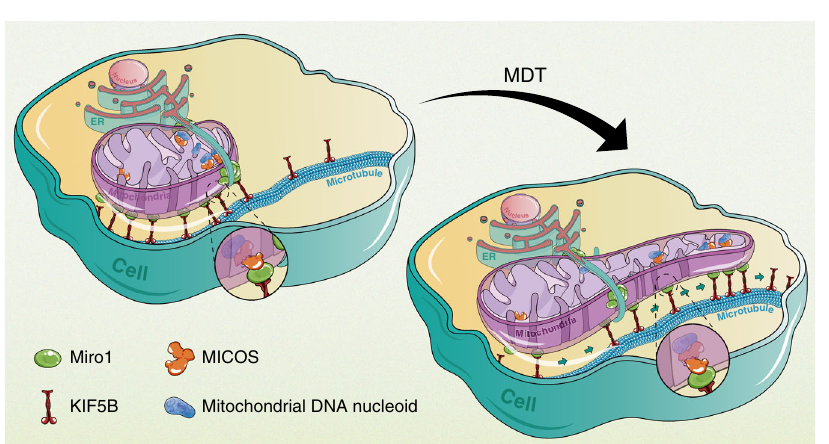
Fig. 5 MDT contributes to nucleoids distribution in peripheral mitochondrial network. a Confocal images of KIF5B − / − NRK cells expressing mito-YFP, TFAM-mCherry, and TET-ON-KIF5B and treated with 0.5 µ g/ml tetracycline. Higher magni fi cations of the white dashed boxes are in the lower panels. Red dashed lines indicate the mitochondrial network boundary before tubulation. b – d KIF5B − / − NRK cells expressing mito-YFP, TFAM-mCherry, and TET-ON- KIF5B were treated with 0.5 µ g/ml tetracycline for 1 h ( b , c ) and 2 h ( d ). White arrows indicate a dynamic tubule. Orange arrowheads indicate nucleoids. e Kymographs of mtDNA labeled by DNA dye picogreen in a control cell and a Mic60 RNAi cell. f Time-lapse images of Mic60 RNAi cells expressing mito- DsRed and stained by picogreen. White arrowheads indicate MDT processes. Orange arrowheads mark the sites of mtDNA. g Percentage of MDT events that drive mtDNA transportation to total MDT events in control and in Mic60 RNAi cells over a 5-min course ( n = 10 cells were used per condition from three independent experiments). h KIF5B − / − NRK cells expressing mito-YFP, TFAM-mCherry, and TET-ON-KIF5B contain control or Mic60 siRNA. Both control and Mic60 RNAi cells were treated with 0.5 µ g/ml tetracycline for 4 h. Yellow dashed lines indicate the boundary of the mitochondrial network. Red dashed lines indicate the boundary of the perinuclear mitochondria. Inset regions are magni fi ed from the boxed areas. i Western blots of Mic60 indicate depletion of Mic60 in lysates of cells transfected with siRNA against Mic60. j Quanti fi cation of nucleoids density in the perinuclear zone and peripheral zone of control or Mic60 RNAi cells after adding 0.5 µ g/ml tetracycline for 4 h ( n = 20 cells were used per condition from three independent experiments). Scale bars: a , h , 10 μ m; inset in a , 5 μ m; b – d , f and inset in h , 2 μ m; e , 1 μ m. Data are presented as mean ± SEM. P value from top to bottom and left to right: p < 0.0001, p = 0.7101, p = 0.0006. NS no signi fi cant difference; *** p < 0.001, two-tailed, unpaired Student ’ s t -test. Source data are provided as a Source data fi le.